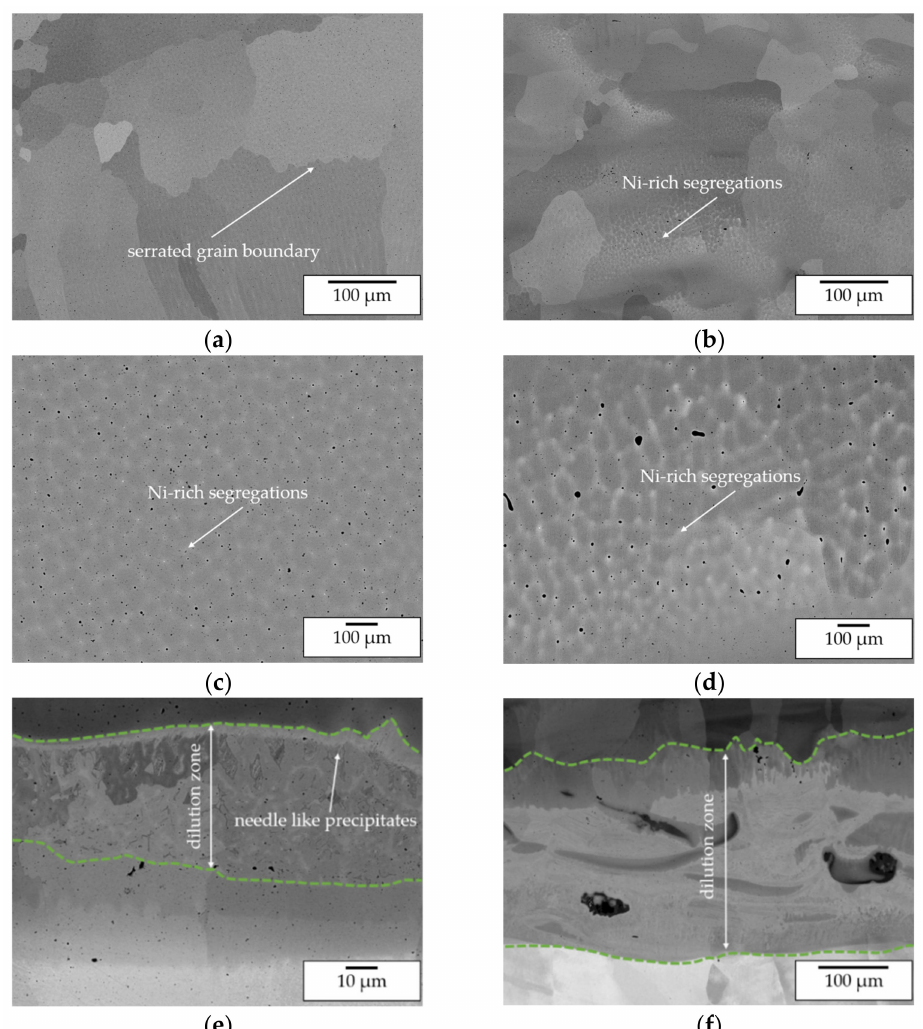
Figure 16. SEM images of manufactured wall specimens—( a ) top layer, pre-alloyed powder processing; ( b ) top layer, in situ alloying; ( c ) Ni-rich segregations, pre-alloyed powder processing; ( d ) Ni-rich segregations, in situ alloying; ( e ) transition zone, pre-alloyed powder processing; ( f ) transition zone, in situ